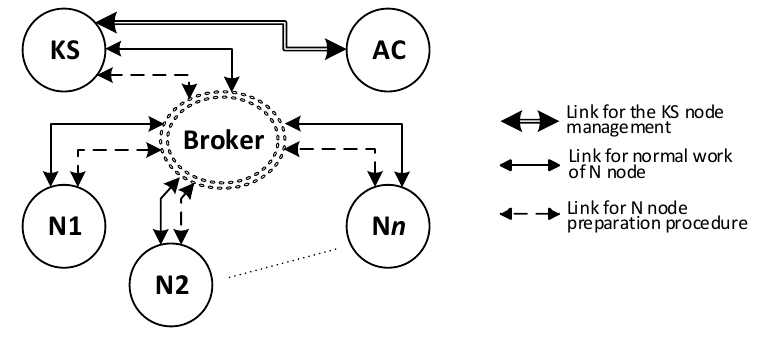
Figure 4. Structure of a Key Exchange Domain.